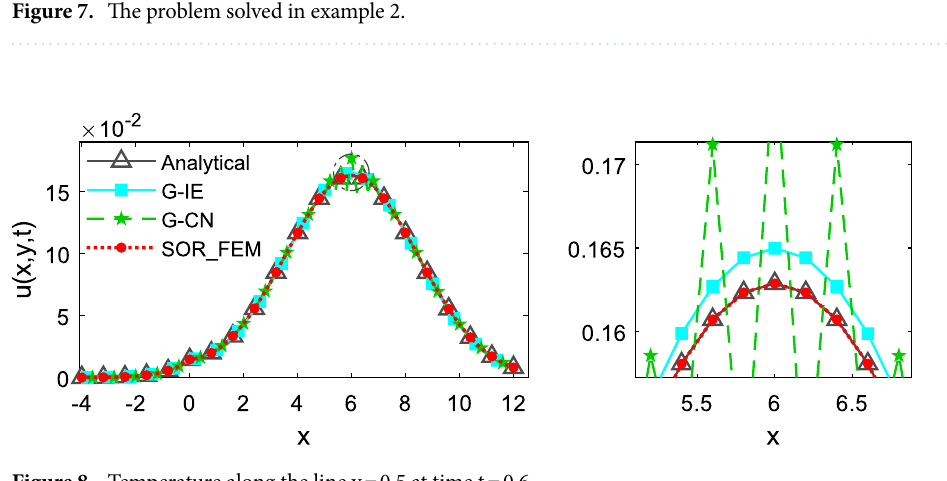
Figure 8. Temperature along the line y = 0.5 at time t =